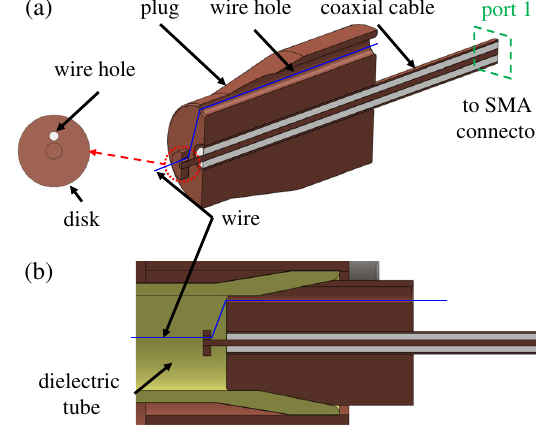
FIG. 9. (a) Mode launcher used during the cold test together with a magnified view of the disk. (b) Insertion of the mode launcher into the dielectric-loaded power extractor